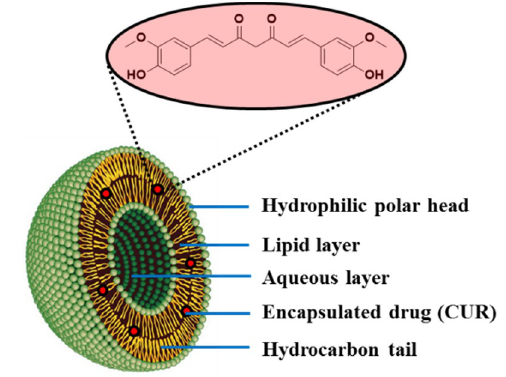
Figure 12. Schematic representation of the inner structure of a liposome drug delivery system with encapsulated CUR.